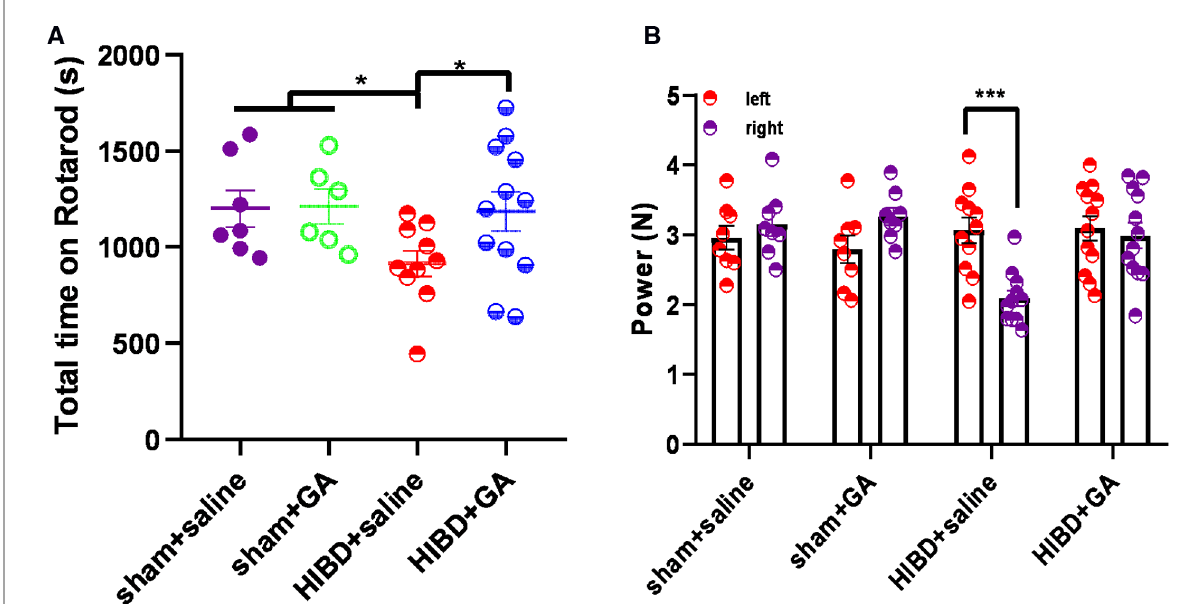
FIGURE 6 Ga alleviates the de fi cits of motor ability and muscle strength in HIBD model rats. (A ) Rats were subjected to HIBD at the postnatal 7th day, GA or saline was injected daily for 2 weeks and the rotarod test was conducted at the 28th day. After the fi rst day of adaptive training, the rats were put on the rotarod for 10 trails on the following day and the time on the rotarod was recorded. GA-treated HIBD rats increased the total time spent on the rotarod compared with the saline-treated HIBD rats (sham+saline, n =7; sham+GA, n =6; HIBD+saline, n =10; HIBD+GA, n =12). (B ) The muscle strength of the left and right fore-limb was evaluated by grasping test. The imbalance muscle strength of the upper limbs caused by HIBD was saved by GA treatment (sham+saline, n =8; sham+GA, n =8; HIBD+saline, n =11; HIBD+GA, n =12). Data are presented as mean±SEM. * P <0.05, ** P <0.01, *** P